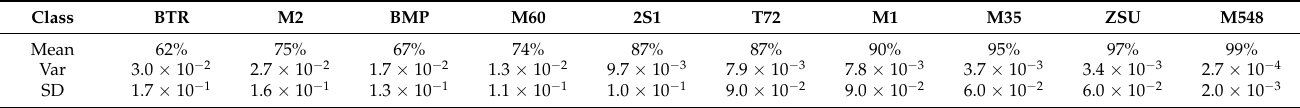
Table 7. Simple net decision fusion intraclass variance (Var) and standard deviation